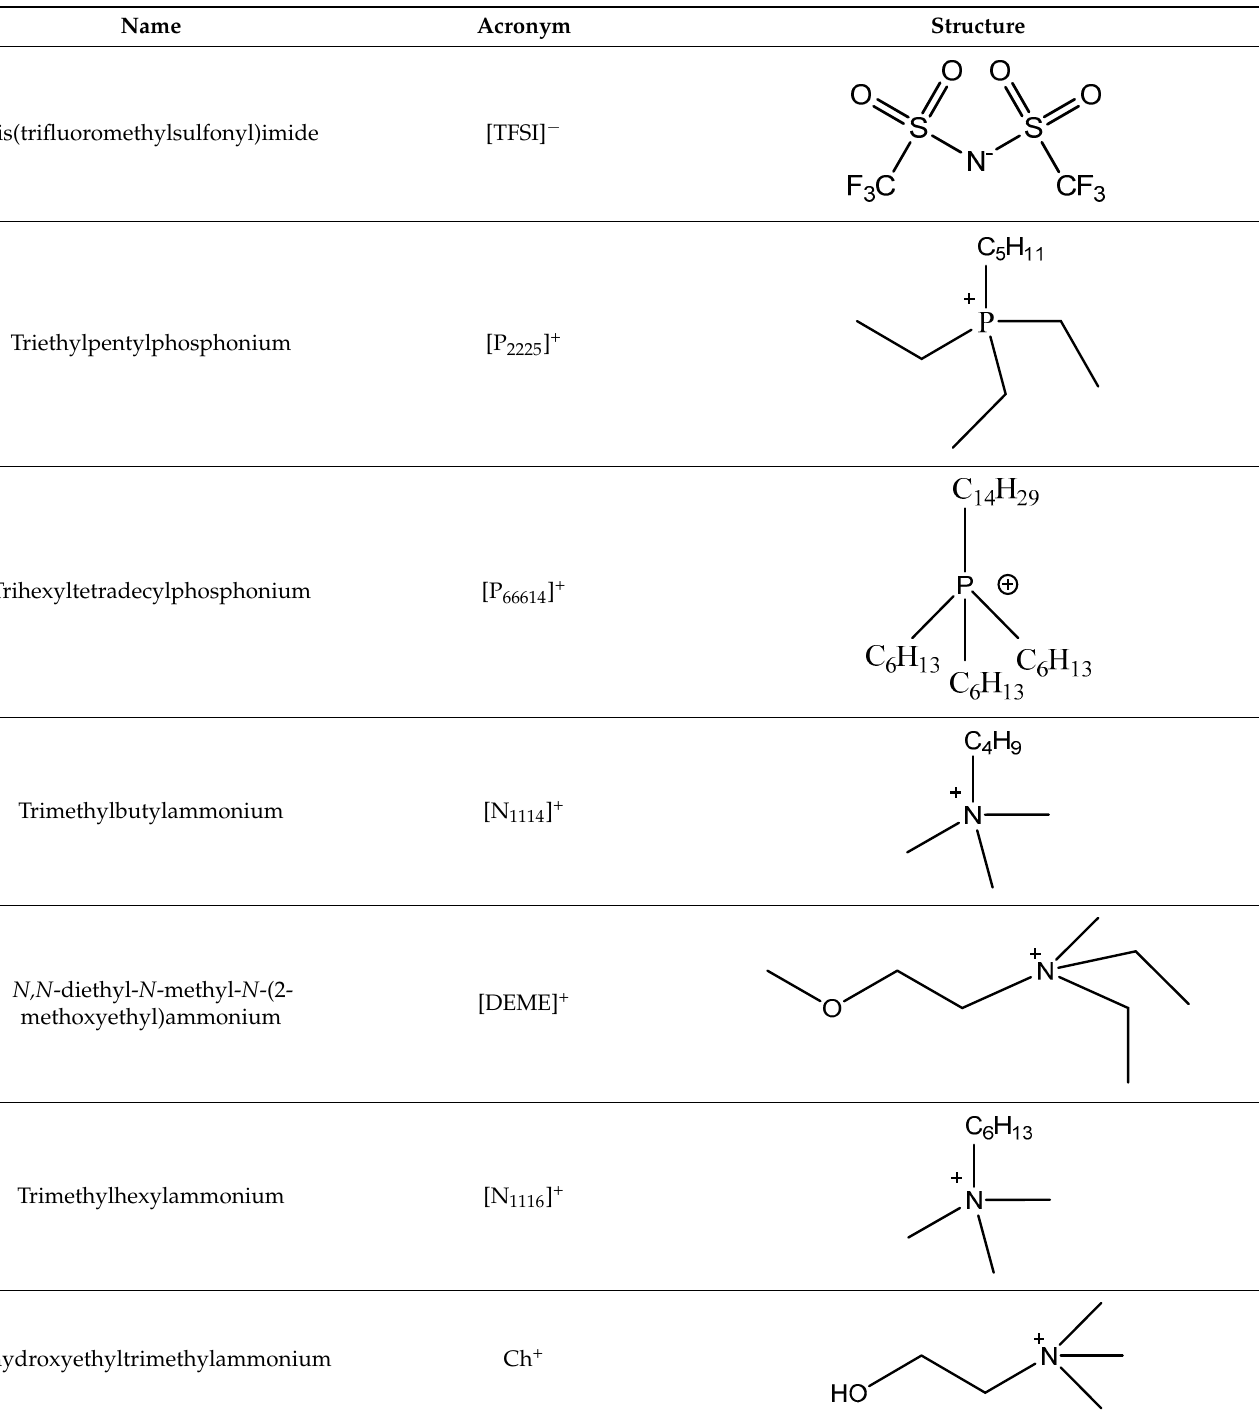
Table 1. Structures and chemical names of different ionic liquid ions used in the electro-recovery of Nd.